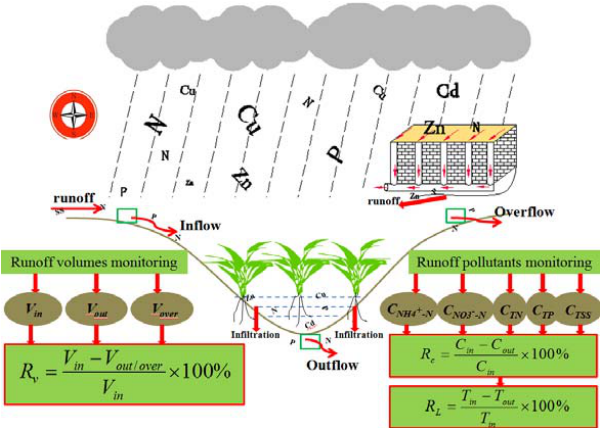
Figure 4. Flowchart. Note: Runoff volumes of inflow, outflow and overflow are monitored for the rainfall event. Runoff reduction rate ( R v ) is calculated at the following time; water samples of inflow, outflow, and overflow are collected for the rainfall event to detect the concentration of runoff pollutants, and concentration removal rate ( Rc ) and pollutant load reduction rate ( R L ) are calculated in the following